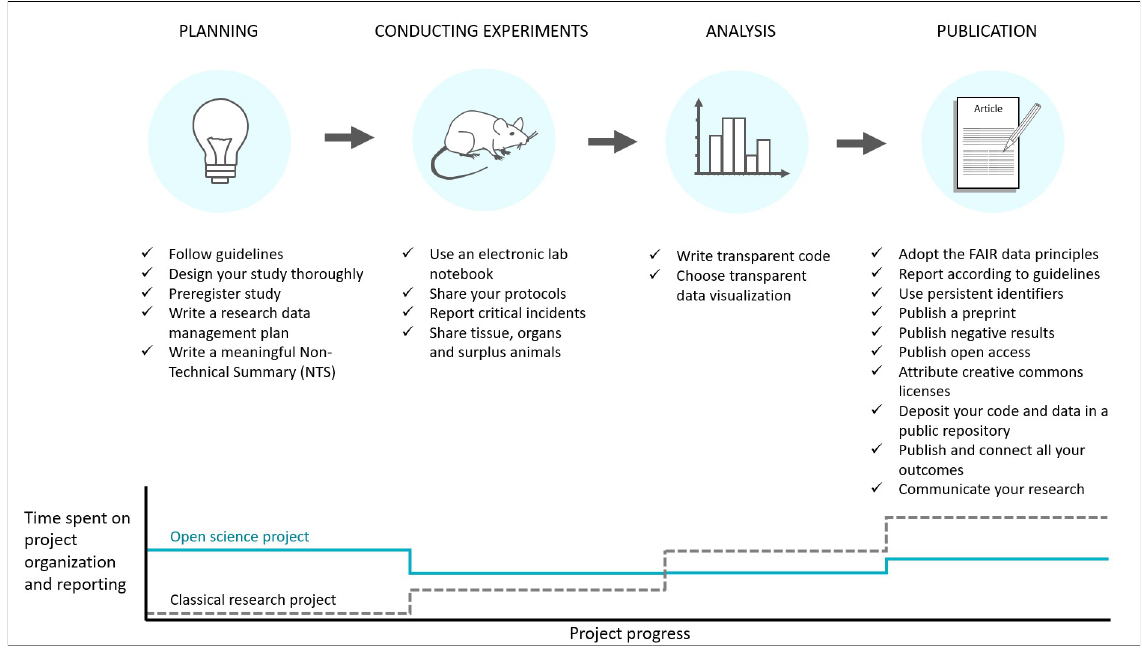
Fig 1. Using open science practices throughout translational research studies. Application of open science practices at each step of the research process can maximize the impact of performed animal experiments. The implementation of these practices will lead to less time pressure at the end of a project. Due to the connection of most of these open science practices, spending more time in the planning phase and during the conduction of experiments will save time during the data analysis and publication of the study. Indeed, consulting reporting guidelines early on, preregistering a statistical plan, and writing down crucial experimental details in an electronic lab notebook, will strongly accelerate the writing of a manuscript. If protocols or even electronic lab notebooks were made public, just citing these would simplify the writing of publications. Similarly, if a data management plan is well designed before starting data collection, analyzing, and depositing data in a public repository, as is increasingly required, will be fast. NTS, non-technical summary.